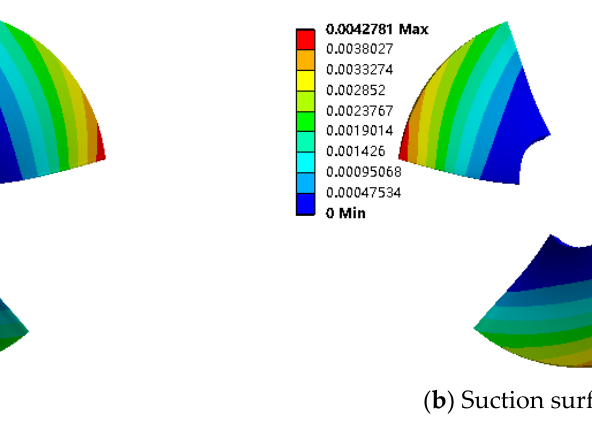
Figure 17. Q = 10 m 3 /s Deformation of impeller, Unit: m.